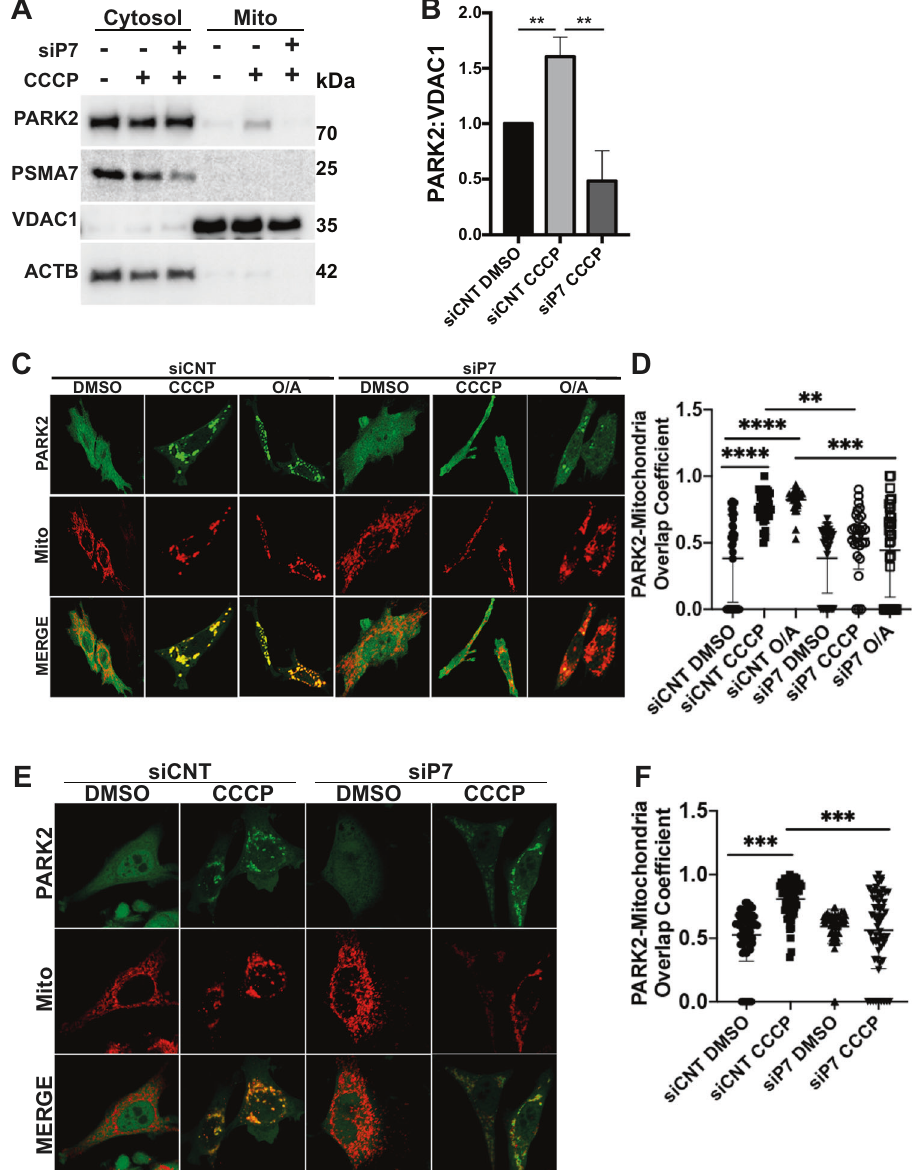
Fig. 4 20 S proteasome subunit PSMA7 and proteasomal activity are indispensable for PARK2 recruitment to mitochondria. A , Representative western blot images showing PARK2, PSMA7, VDAC1 and actin beta (ACTB) protein levels in cytosolic (Cytosol) and mitochondrial (Mito) fractions of YFP-PARK2 expressing HEK 293 T cells transfected with control, non-targeting siRNAs (siCNT) or PSMA7- targeting siRNAs, (siP7) and treated with DMSO or CCCP (10 µM) for 12 h. B Quanti fi cation graph representing mitochondrial PARK2 levels normalized to VDAC1 from A (mean ± SEM, n = 3). C and E , Confocal microscopy analysis of YFP-PARK2 (green) and mito-dsRed (red) expressing and siCNT or siP7 transfected HeLa cells after 2 h ( C , DMSO, 20 µM CCCP or 10 µM O/A) and 12 h ( E, DMSO or 20 µM CCCP) of indicated treatments. MERGE, overlay of green and red signals. D and F Graphs showing quanti fi cations of overlap coef fi cient of PARK2 and mitochondria (mito-dsRed) from C and E respectively (mean ± S.D., n ≥ 30, one-way ANOVA).